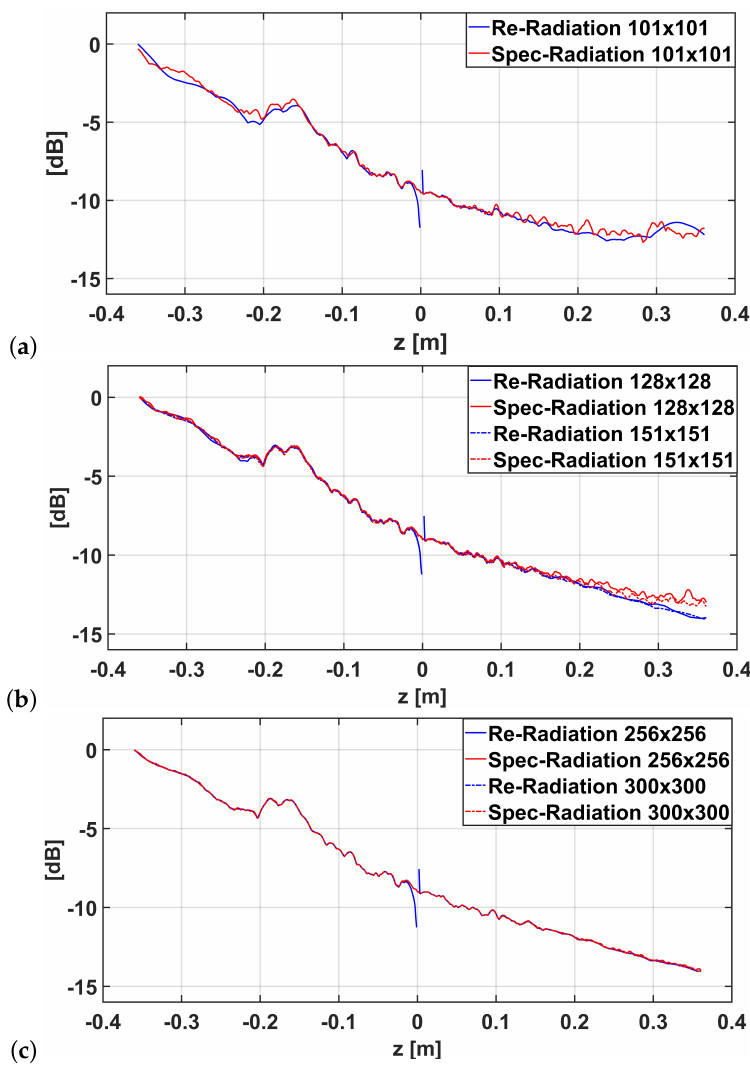
Figure 7. Maximum value of several calculated planes using the re-radiation method for calculation (blue) and with the spec-radiation method for calculation (red). For the grid of the size 101 × 101 points ( a ), for the grid of the size 128 × 128 points and for the grid of the size 151 × 151 points ( b ) and for the grid of the size 256 × 256 points and for the grid of the size 300 × 300 points ( c